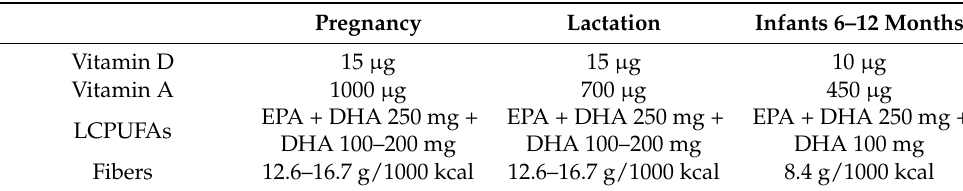
Table 1. Daily reference amounts of nutrients involved in food allergy modulation in critical develop- ment periods, according to LARN 2014